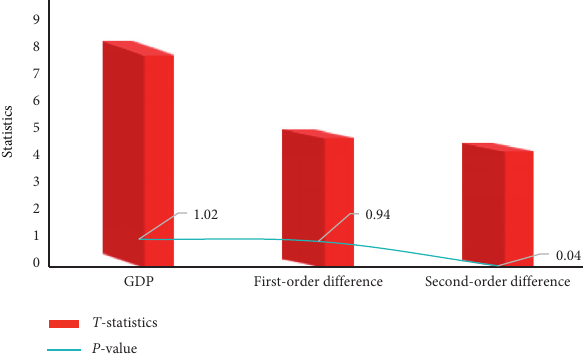
Figure 3: Economic statistics.